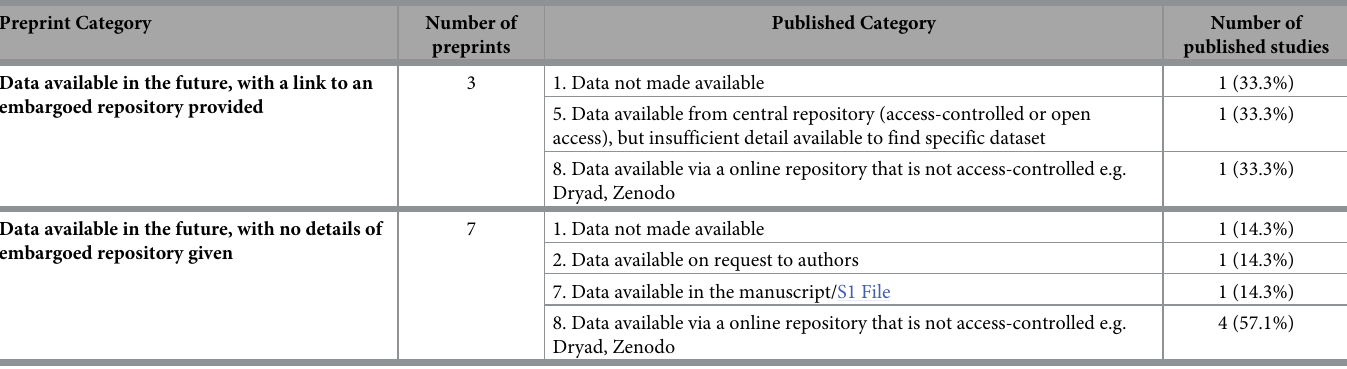
Table 3. Assessment of whether researchers promising to make data available on publication actually do so, and whether this differs if researchers included a link to an embargoed repository or